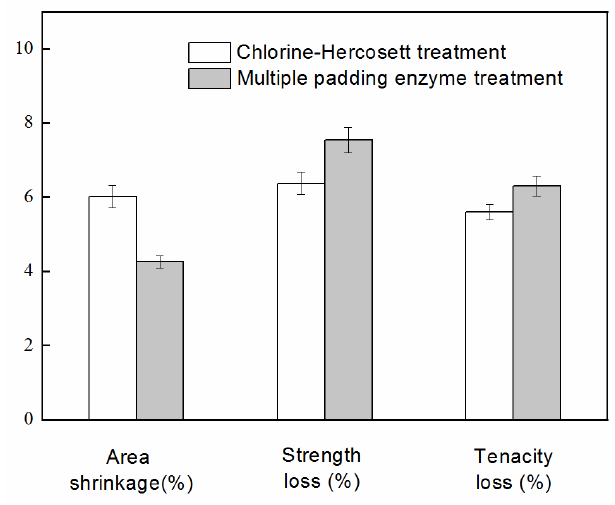
Figure 8. Shrinkage and mechanical properties after treatment. Table 5. Color change after Chlorine-Hercosett treatment and multiple padding enzyme treatment.